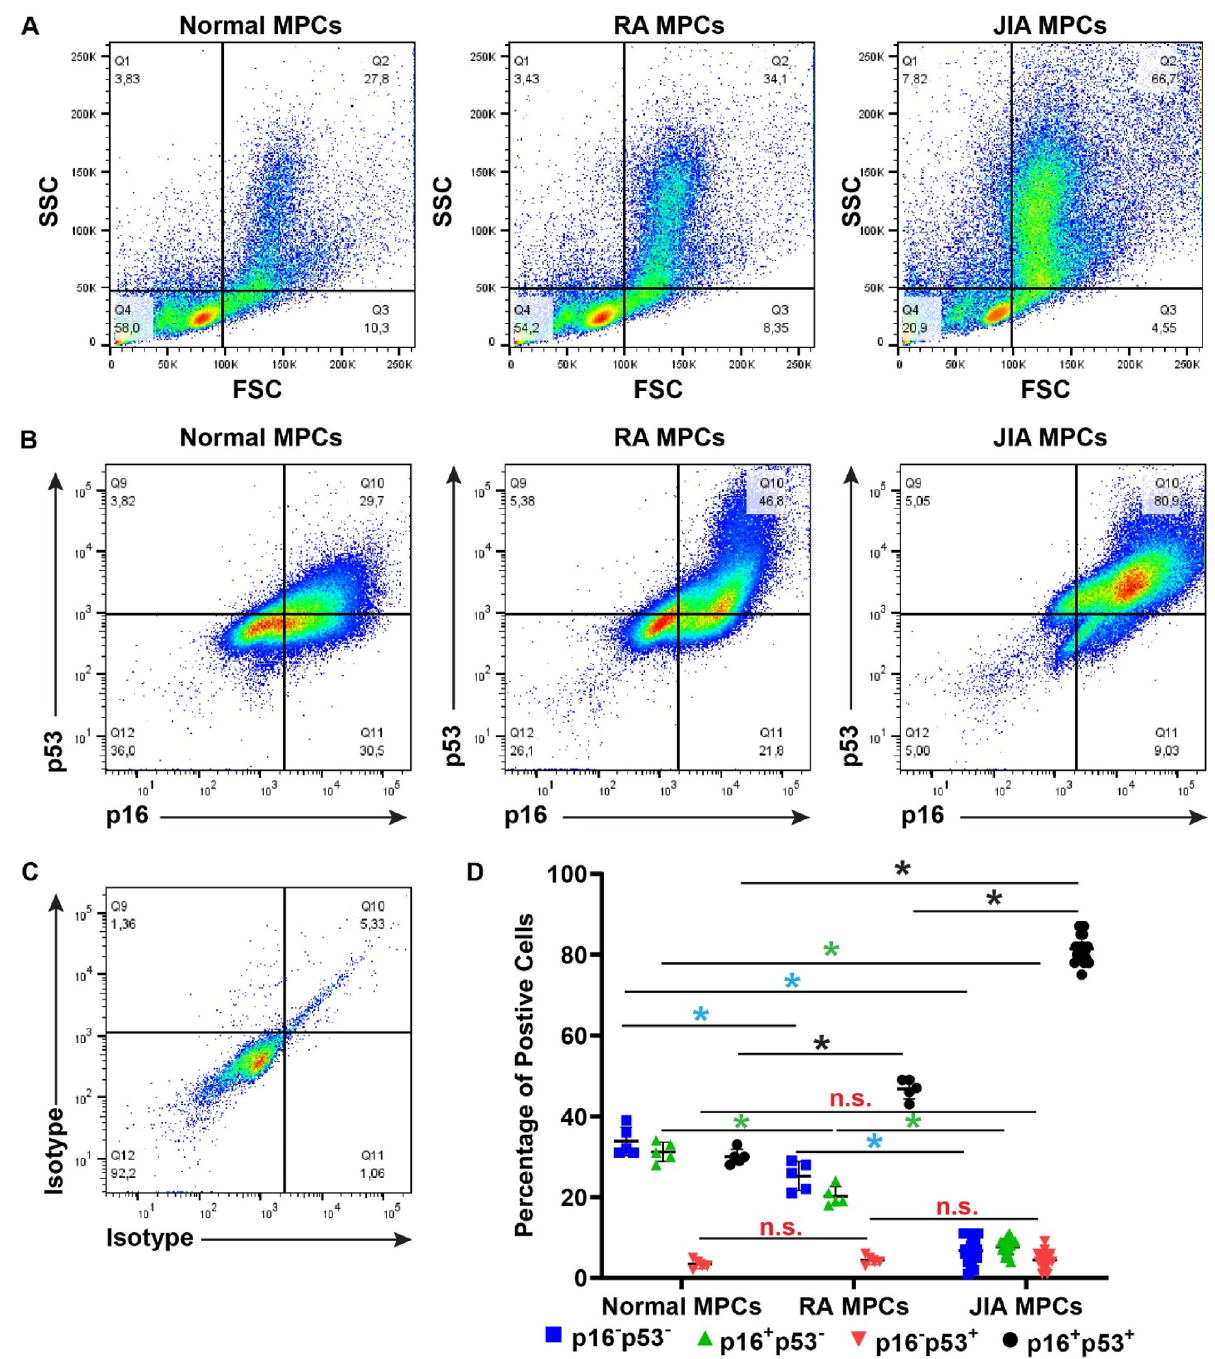
Figure 2. Expression of senescent marker p53 and p16 in MPCs at P10. Synovial MPCs from normal (n = 5), JIA (n = 19) and RA (n = 5) joints were assayed for morphological changes in cell shape/size using flow cytometry ( A ). MPCs from normal, RA and JIA populations were examined for expression of p53 and p16 ( B ). Isotype controls were used to developed thresholds for each marker ( C ). The p16 − p53 − , p16 + p53 − , p16 − p53 + and p16 + p53 + populations were quantified ( D ). *p < 0.05, n.s. = non-significant. Error bars represent mean + /-